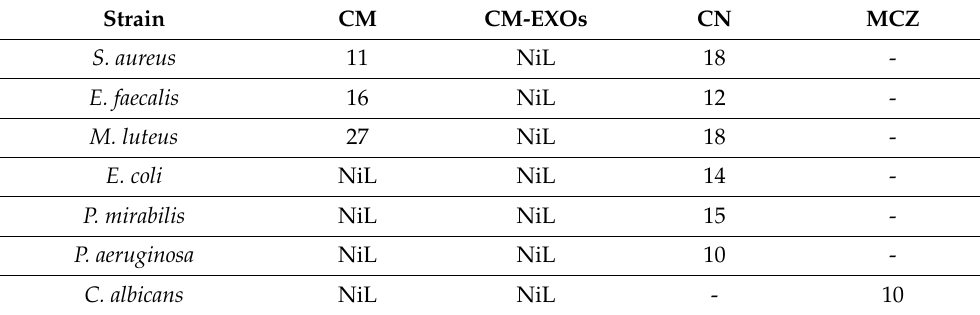
Table 2. Antimicrobial activity as measured by inhibition zone diameter